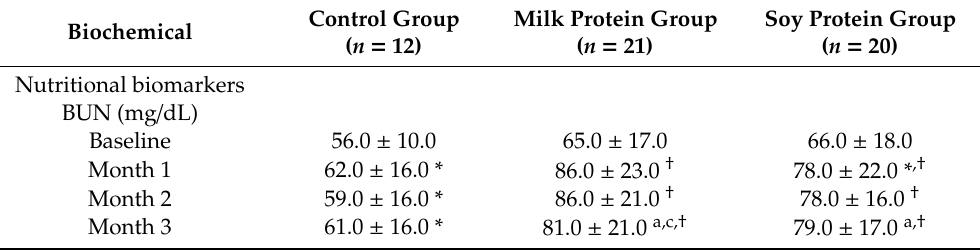
Table 4. Biochemical parameters in di ff erent groups during the intervention.